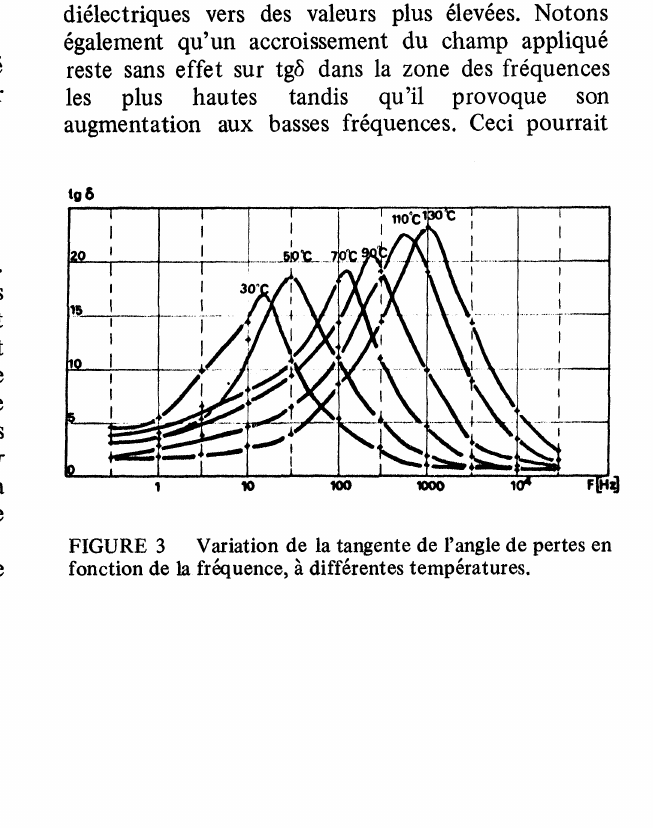
FIGURE 2a et b Diagrammes d’imp6dances t diff6rentes temp6ratures (la partie imaginaire de l’imp6dance a 6t6 port6e